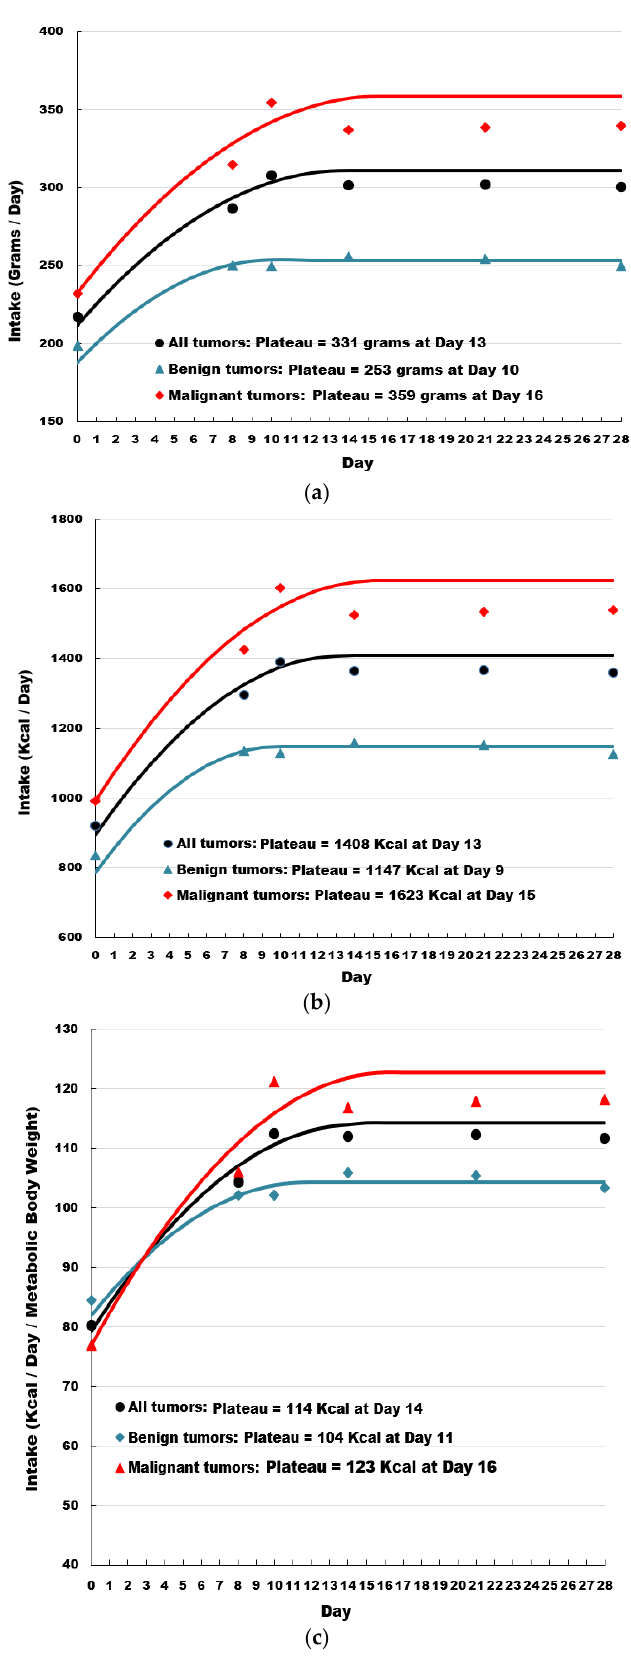
Figure 2. Owner-reported food intake by grams ( a ), calories ( b ), and calories per metabolic body weight ( c ).